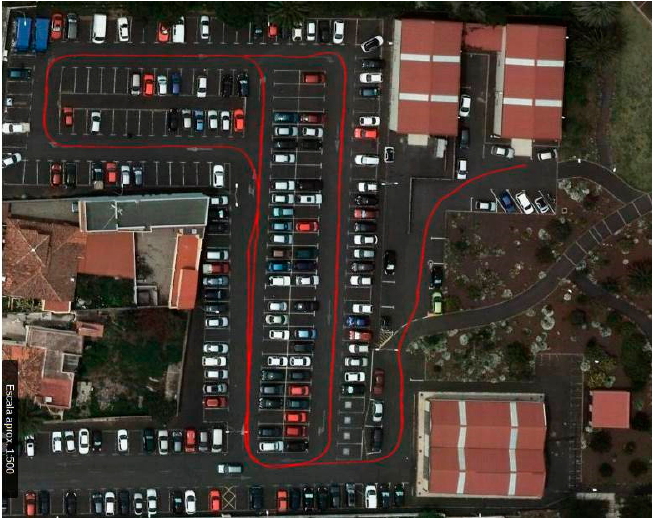
Figure 3. Parking of Computer Science in University of La Laguna, in red the actual path traveled in the experiments.